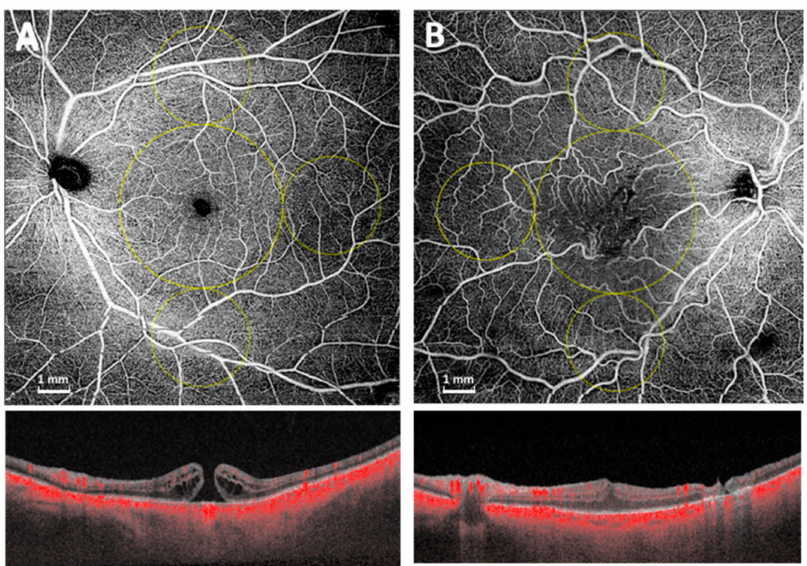
Figure 1. Widefield OCTA scan (12 × 12 mm) of superficial capillary plexus and structural OCT of macular hole ( A ) and epiretinal membrane ( B ). The quantitative analysis was performed in the macular region, which was defined as a circular annulus around the fovea with diameter of 5 mm, excluding the foveal avascular zone and in the midperiphery 3 circles (temporal, superior and inferior of 3